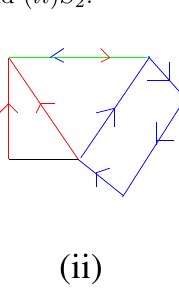
Figure 10 . The graphs ( i ) S 3 and ( ii ) S 4 .